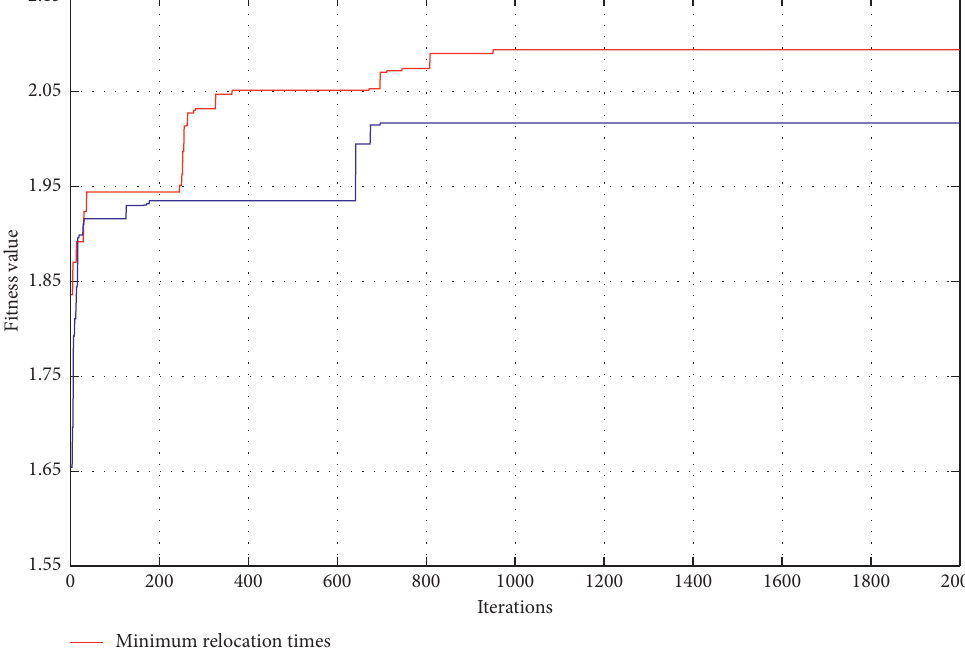
Figure 11: GA-simulation convergence curves.